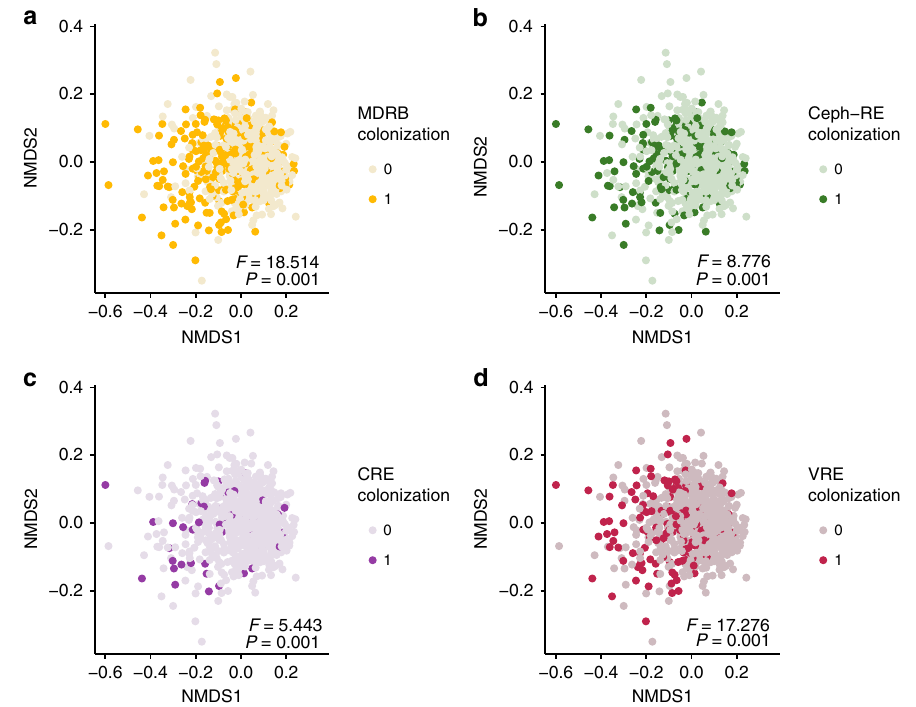
Fig. 1 Signi fi cant clustering of samples collected during colonization by multidrug-resistant bacteria (MDRB). Nonmetric multidimensional scaling (NMDS) plots were constructed by using UniFrac β -diversity. Each point represents a single sample in the full data set ( n = 703). The difference in microbiome community structure was compared during versus not during colonization by ( a ) any MDRB (dark yellow; colonized n = 254 vs. noncolonized n = 449), b vancomycin-resistant enterococci (VRE, dark pink; colonized n = 142 vs. noncolonized n = 561), c Enterobacteriaceae resistant to third-generation cephalosporins (Ceph-RE, dark green; colonized n = 162 vs. noncolonized n = 541), and d carbapenem-resistant Enterobacteriaceae (CRE, dark purple; colonized n = 46 vs. noncolonized n = 657) as identi fi ed by using culture-based methods (see Methods, Supplementary Methods). PERMANOVA pseudo- F-statistic and P -value are shown. Source data are provided as a Source Data fi